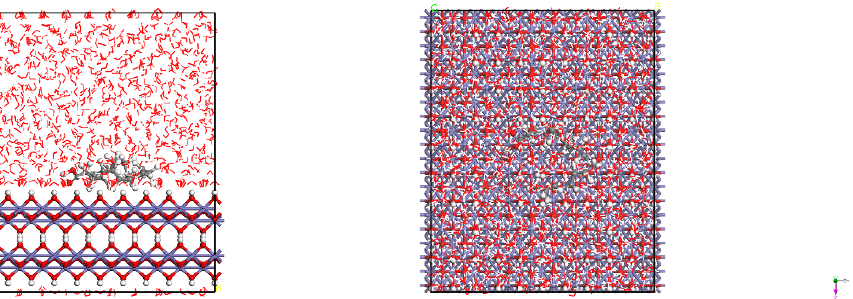
Figure 18. The adsorption configuration of α -linolenic acid molecule on γ -FeOOH (010) surface.